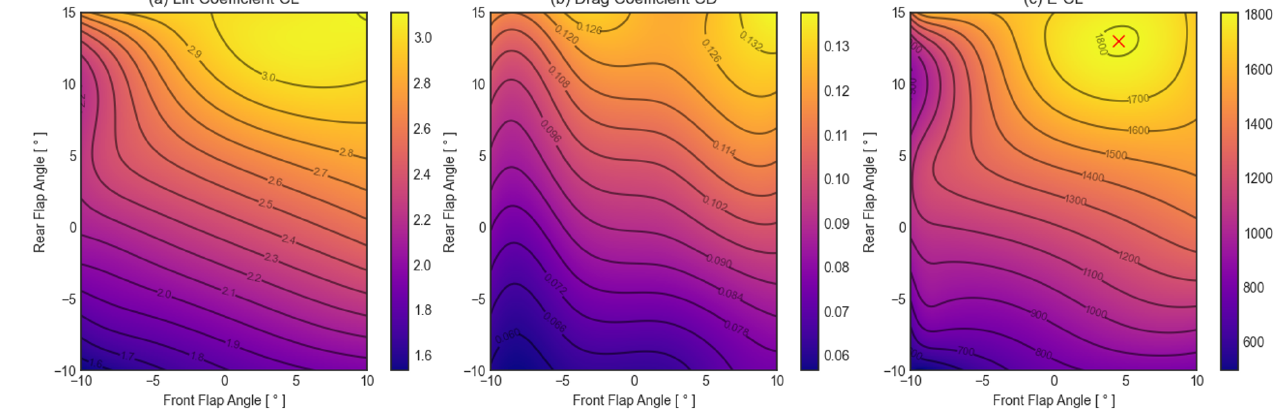
Figure 16. Effect of relative flap angles on (a) C L , (b) C D and (c) E 2 C L .